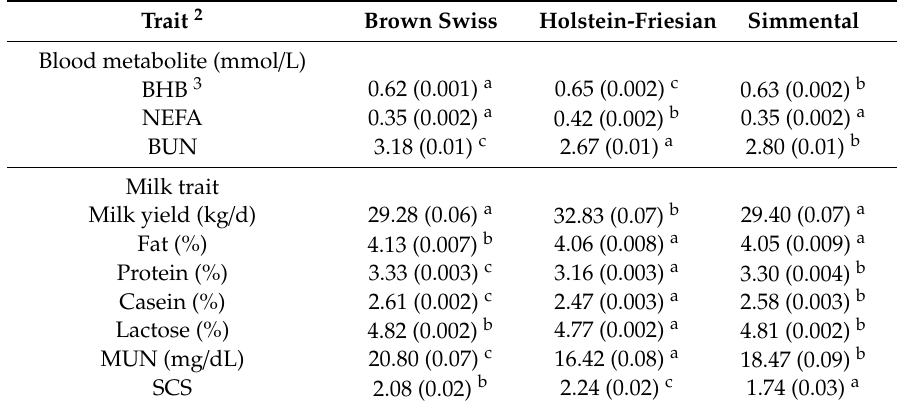
Table 3. Least squares means 1 (standard error) of predicted blood metabolites, milk yield, and composition traits of Brown Swiss, Holstein-Friesian, and Simmental cows in multi-breed